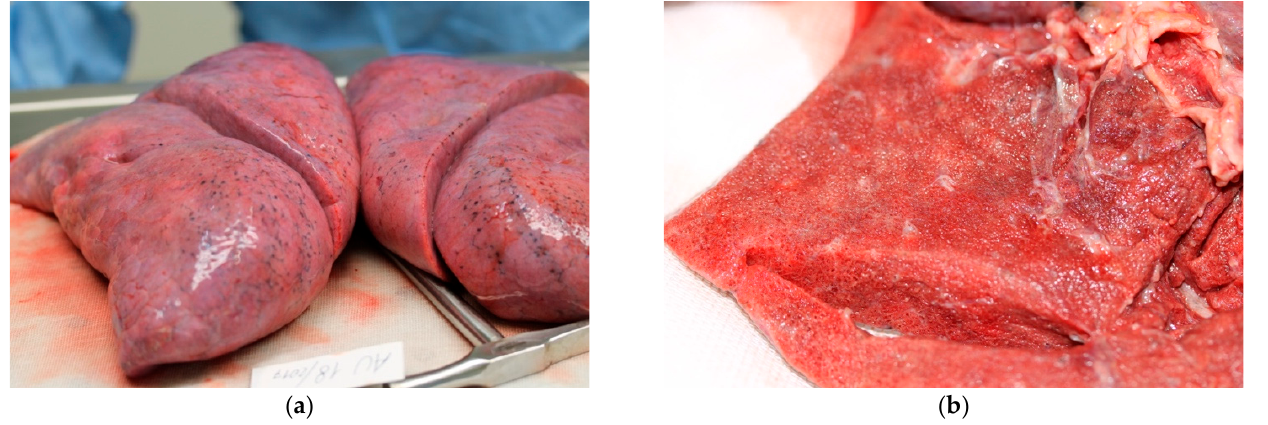
Figure 2. Lungs, macroscopic findings. ( a ) Hyper-inflated and consolidated lungs with thick margins; ( b ) on section, pulmonary tissue appears compact and porous.